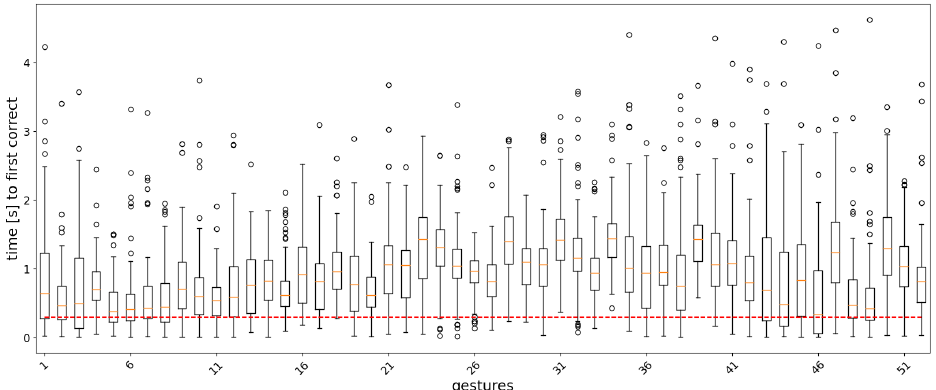
Figure 7. Boxplots of the distribution of the time to the first correct prediction per gesture for the AoT2500 model. The boundaries of the boxes correspond to the Q1 and Q3 quartiles, the boundaries of the standard deviations are Q1 − 1.5IQR and Q3 + 1.5IQR, where IQR = Q3 − Q1, and the circles correspond to outliers. The red dashed line corresponds to 300 ms.